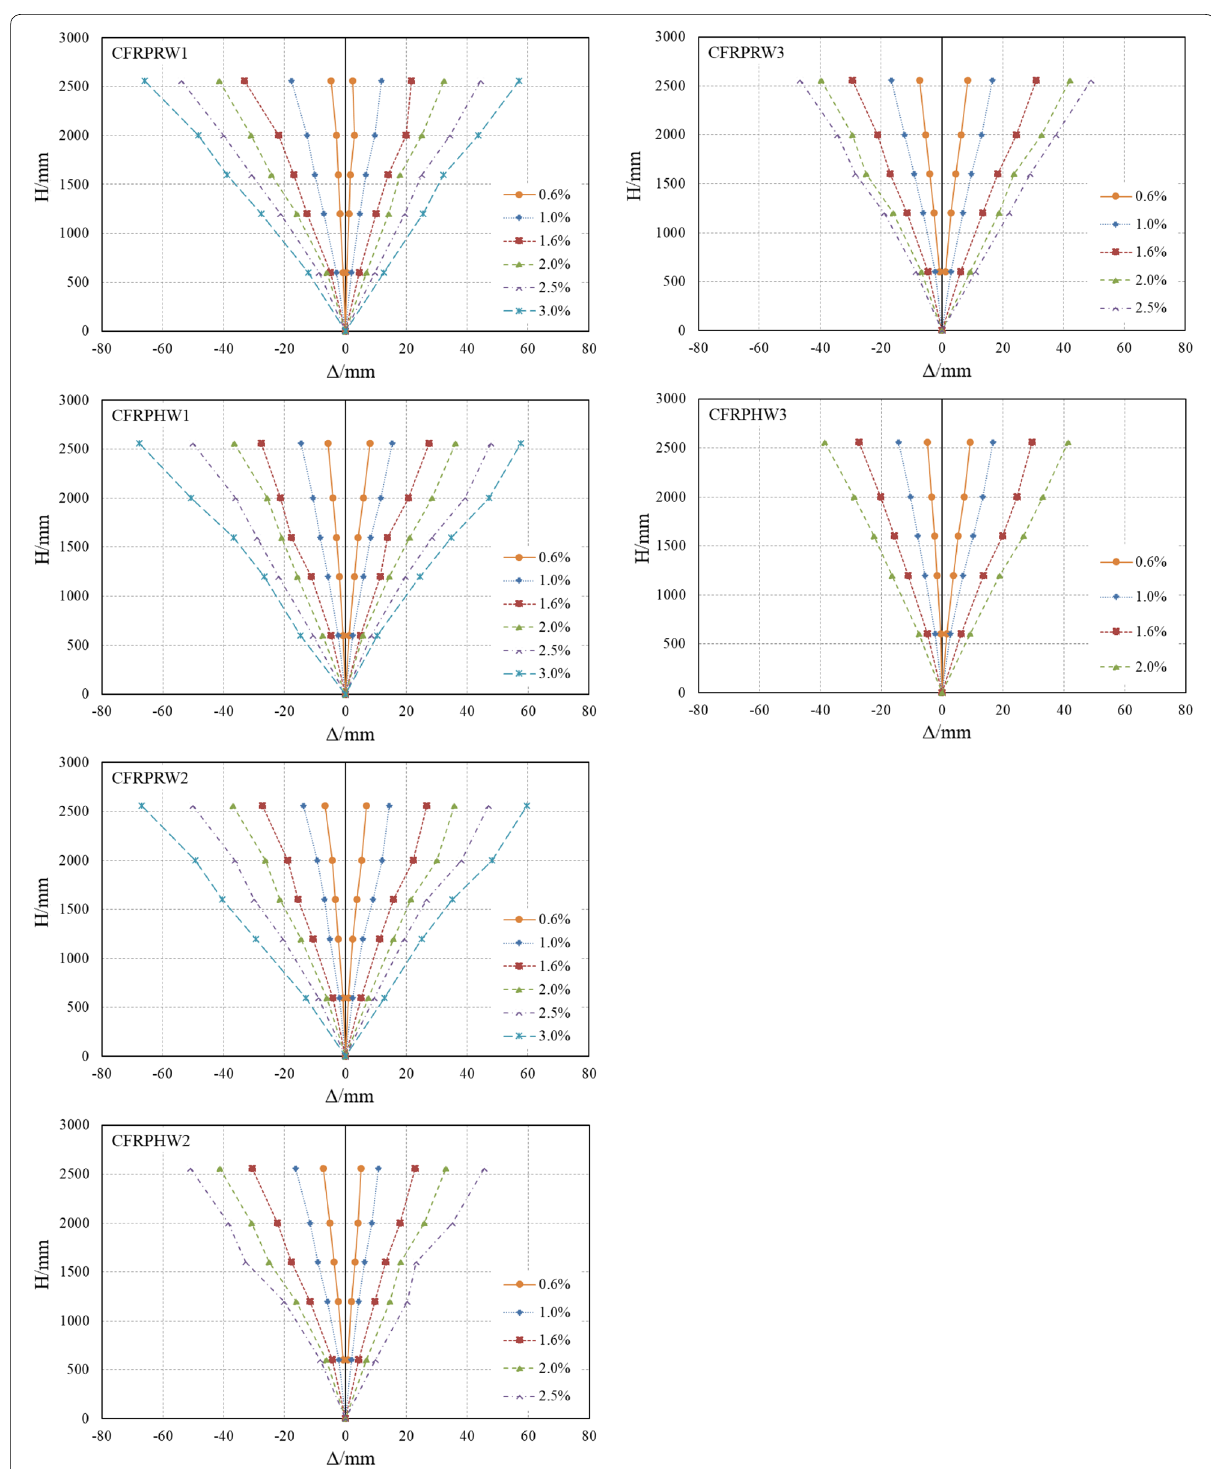
Fig. 11 Lateral displacement